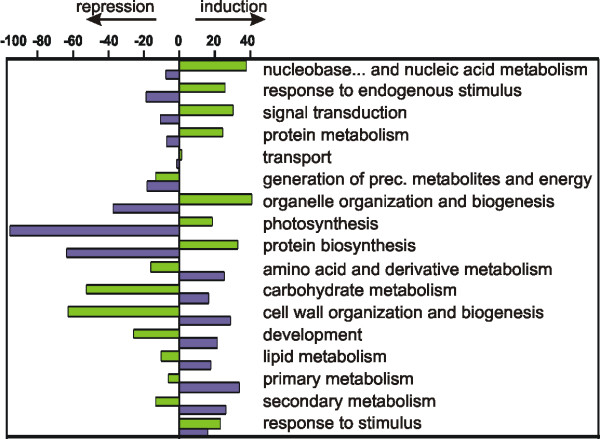
Functional categories distribution before and after-véraison. Induced and repressed functional categories during the first stage (from TP A to TP B, green histograms) derive from clusters 1, 2, 3 and 5, 6, 7, respectively, while categories induced and repressed during the second stage (from TP B to TP C, violet histograms) derive from clusters 3, 4, 5 and 1, 7, 8, respectively. The relative number of induced (Ni) or repressed (Nr) genes for a specific functional category was calculated with respect to the total number of induced or repressed genes in each stage. The estimate of induction or repression within each functional category was then calculated as follows: estimate of induction/repression = (Ni - Nr)/(Ni + Nr). Positive values represent an overall induction and negative values an overall repression.